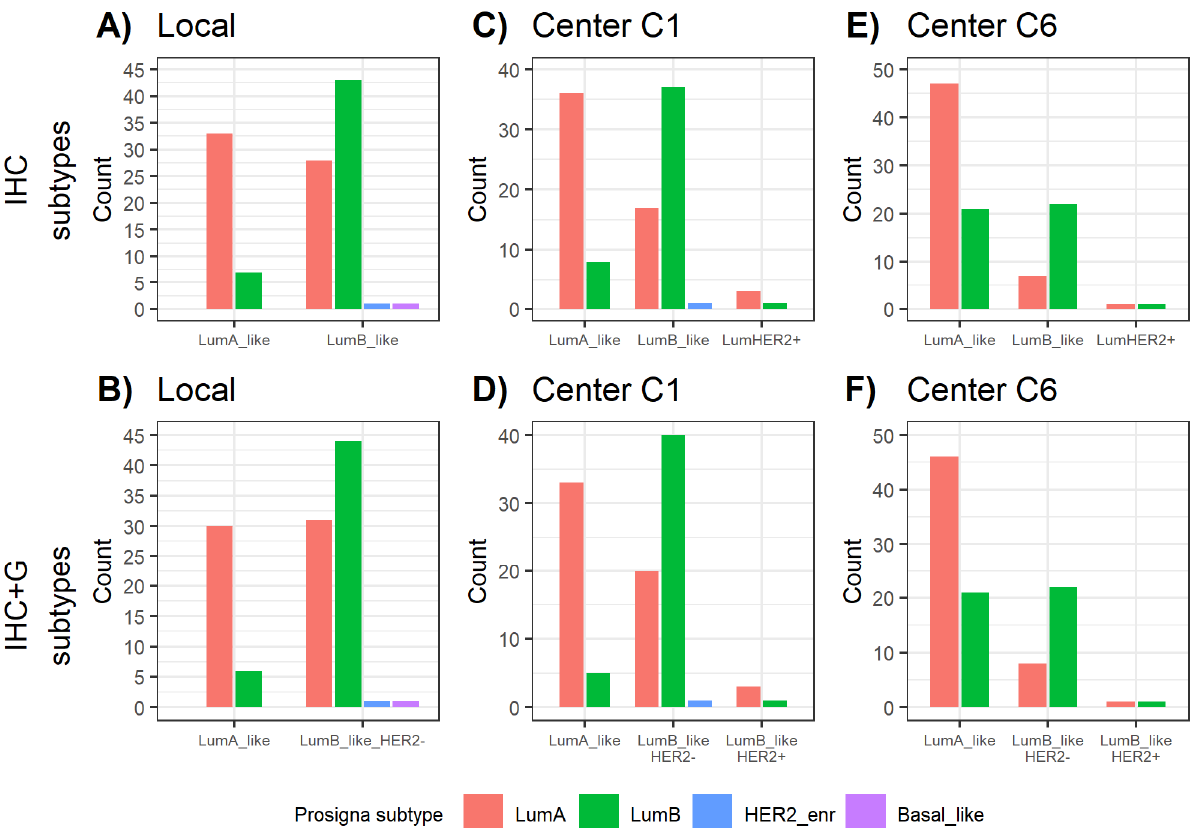
Figure 1. Distribution of Prosigna®subtypes across ( A ) local IHC subtypes, ( B ) local IHC+G subtypes,